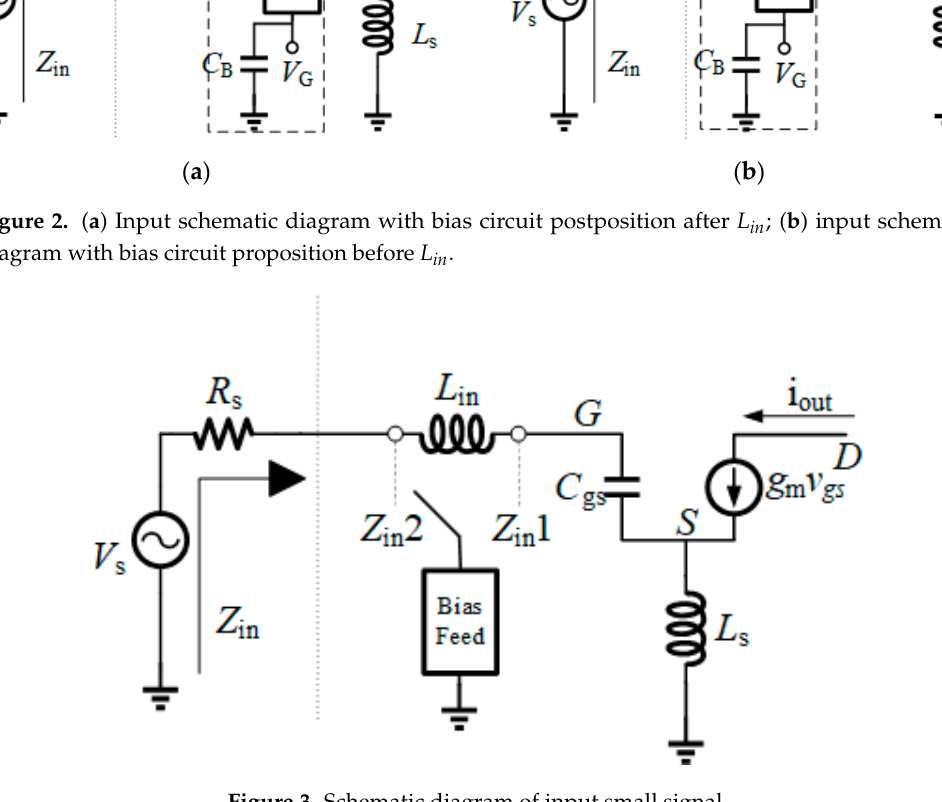
Figure 3. Schematic diagram of input small signal.